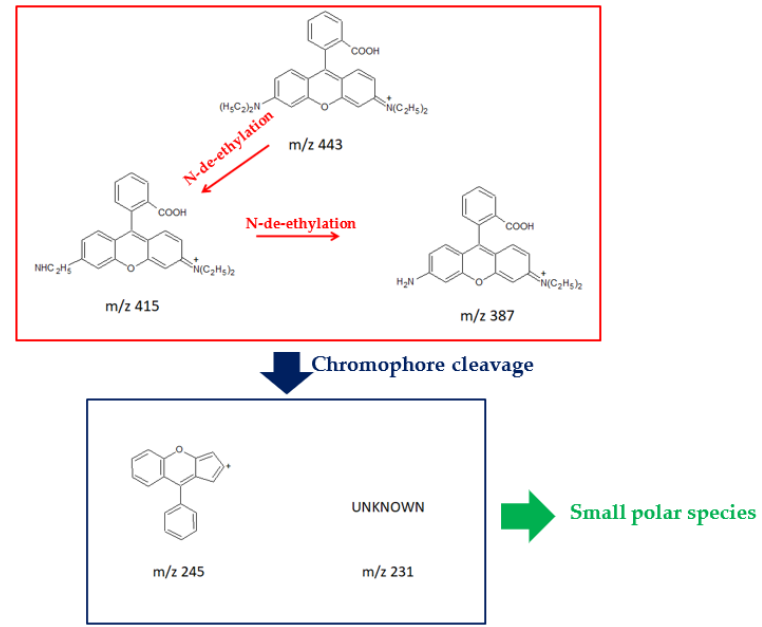
Figure 7. identified RHB